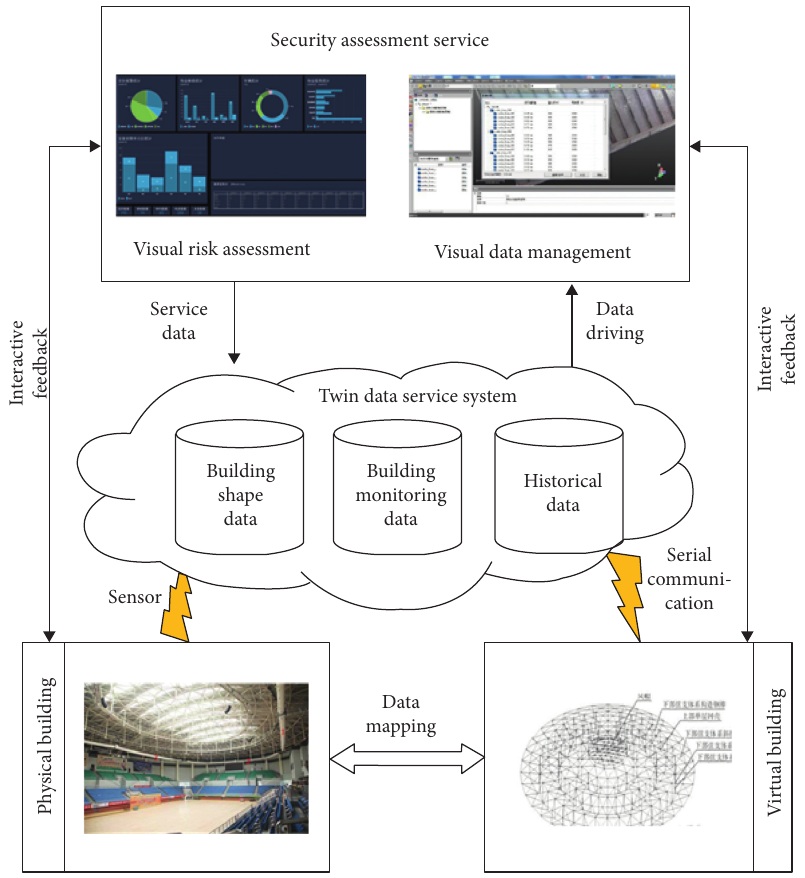
Figure 1: Framework of structural safety